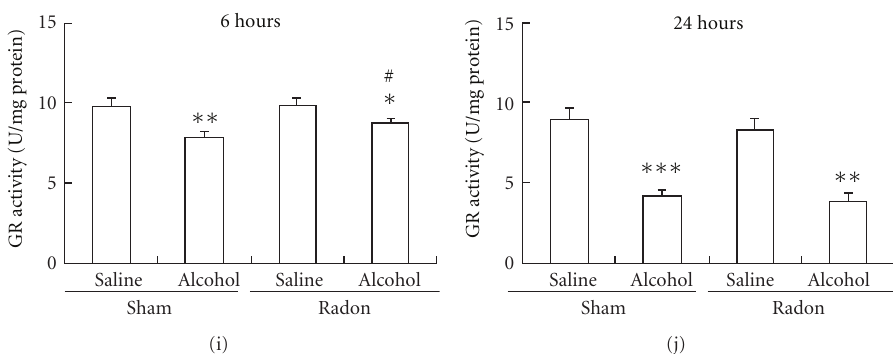
Figure 5: E ff ects of radon inhalation on antioxidative-associated parameters in mouse liver after alcohol administration. Each value indicates the mean ± SEM. The number of mice per experimental point was 5-6. ∗ P < 0 . 05, ∗∗ P < 0 . 01, and ∗∗∗ P < 0 . 001 versus each saline- administrated mice, # P < 0 . 05, versus sham inhaled and alcohol-administrated mice, and + P < 0 . 05, ++ P < 0 . 01 versus sham-inhaled and saline-administrated